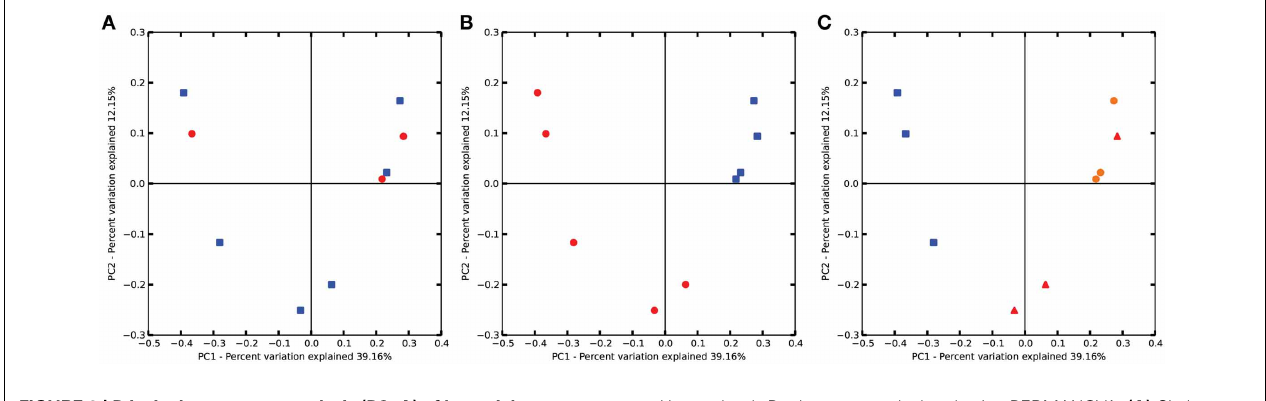
pH or orchard. P -values were calculated using PERMANOVA. (A) Circle, treated with streptomycin; square, treated with water; (B) circle, low pH; square, neutral pH; (C) triangle, Güttingen orchard; circle, Wädenswil orchard; square, Lindau